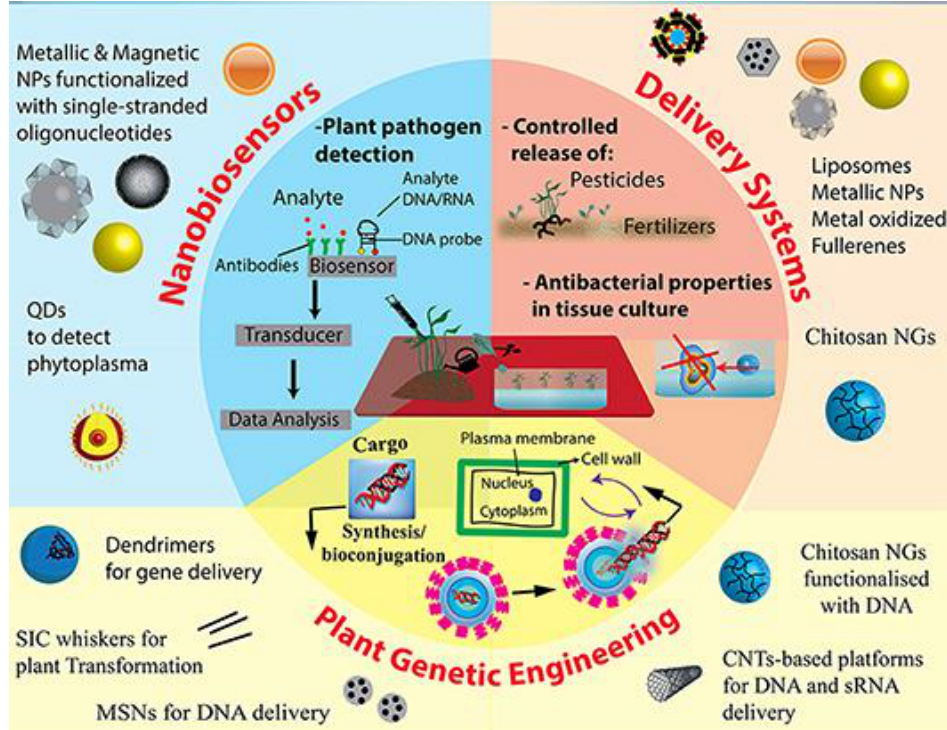
Figure 4. Different application of plant-based gums and mucilages in nanomedicine [177]. Table 3. Some applications of gums and mucilages in nanomedicine.